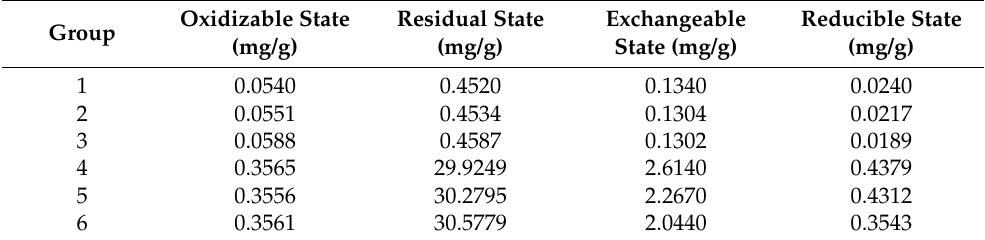
Table 5. Comparison of different forms of heavy metal Ni in soil samples after six groups of different treatments. Oxidizable State Residual State Exchangeable Reducible State Group (mg/g) (mg/g) State (mg/g) (mg/g) 1 0.0540 0.4520 0.1340 0.0240 2 0.0551 0.4534 0.1304 0.0217